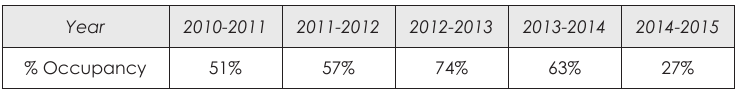
Table 3: Subject silo